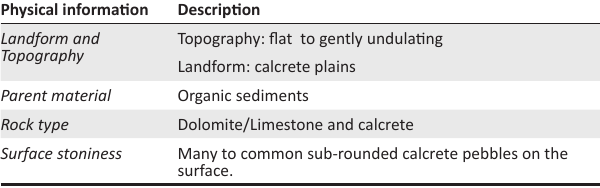
TABLE A1.5a: Differentiating characteristics of the molic Leptosols.